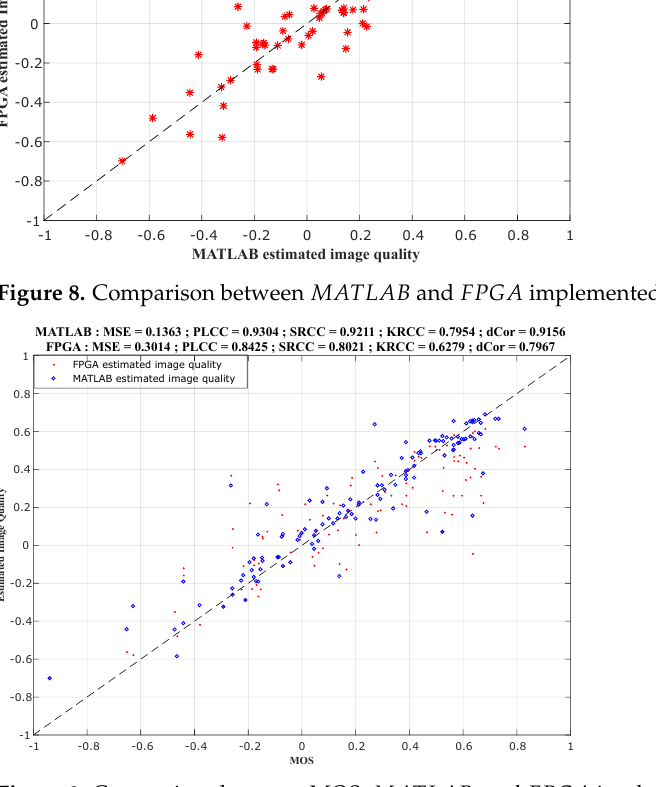
Figure 9. Comparison between MOS, MATLAB , and FPGA implemented